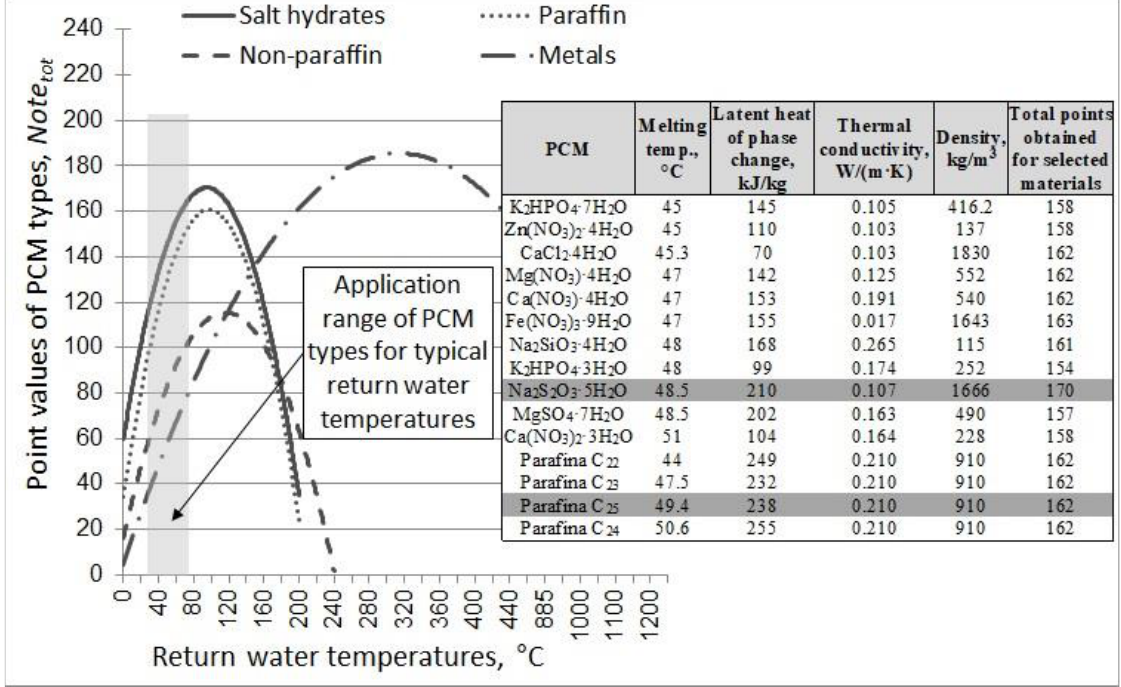
Figure 8. Scoring results of the PCM